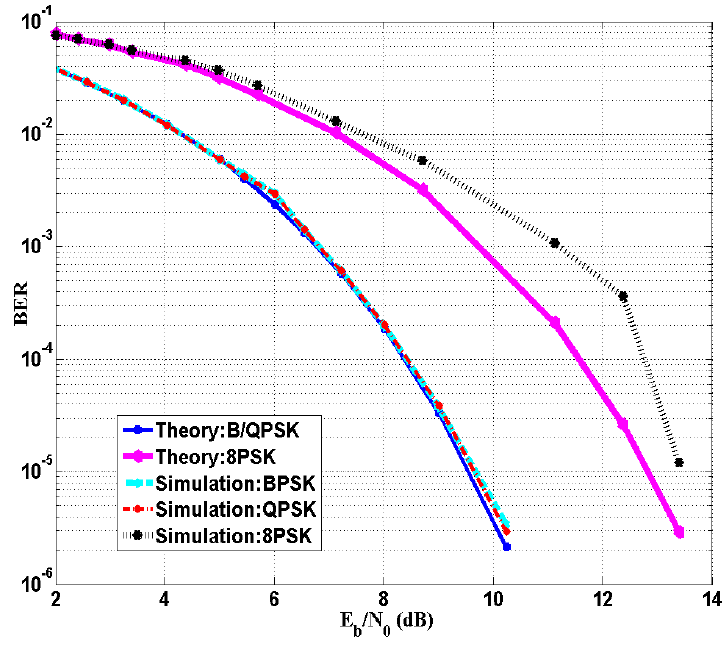
Figure 9. Performance of BPSK, QPSK and 8PSK versus SNR in simulation and theory at S = 11